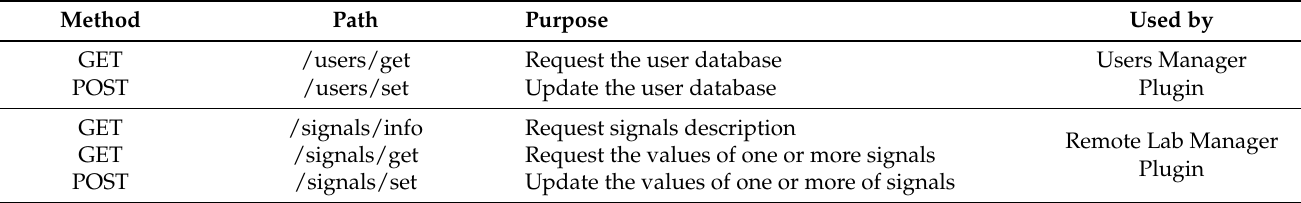
Table 1. Methods of the REST API exposed by the remote lab